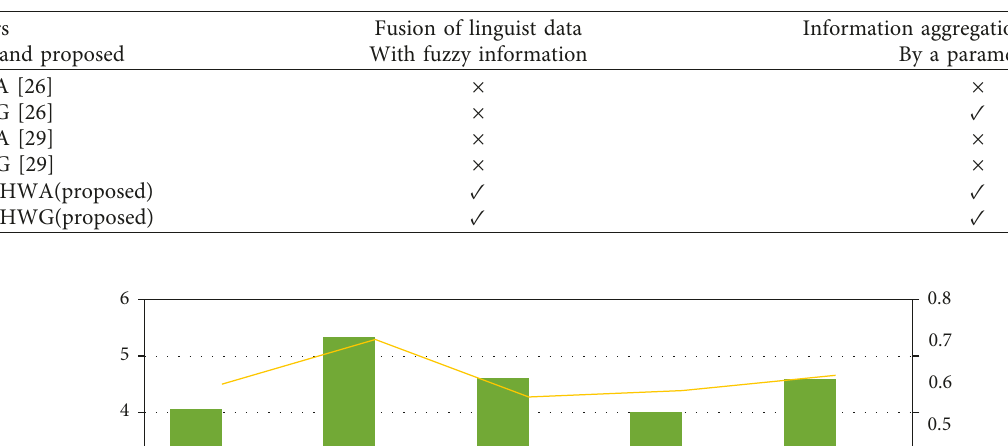
Table 11: Characteristics comparison of 2 TL m F operators with existing structures.